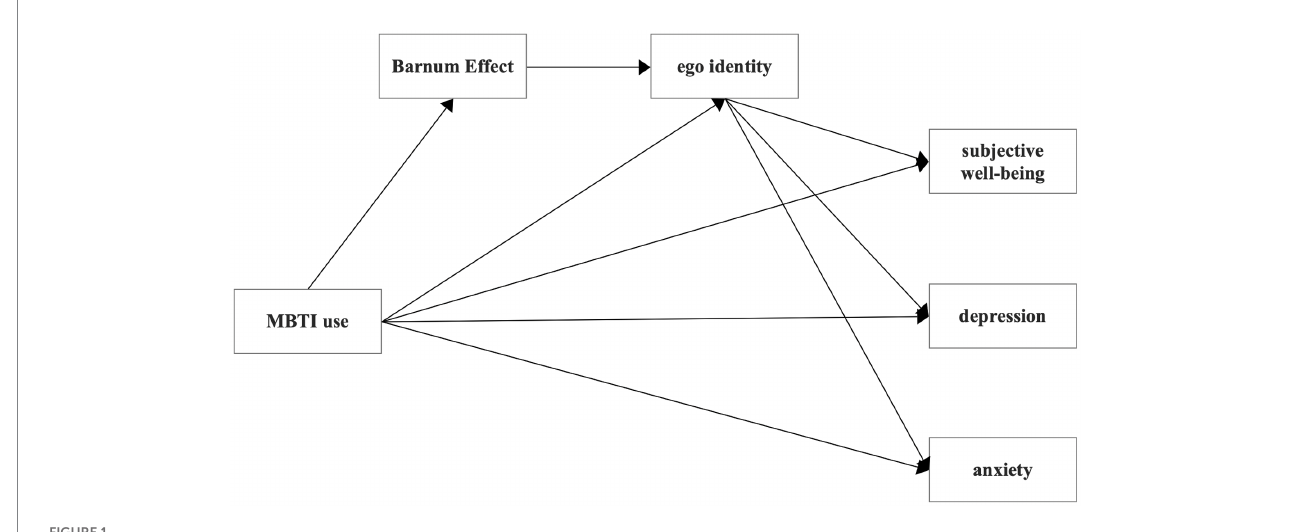
FIGURE 1 Diagrams of the proposed